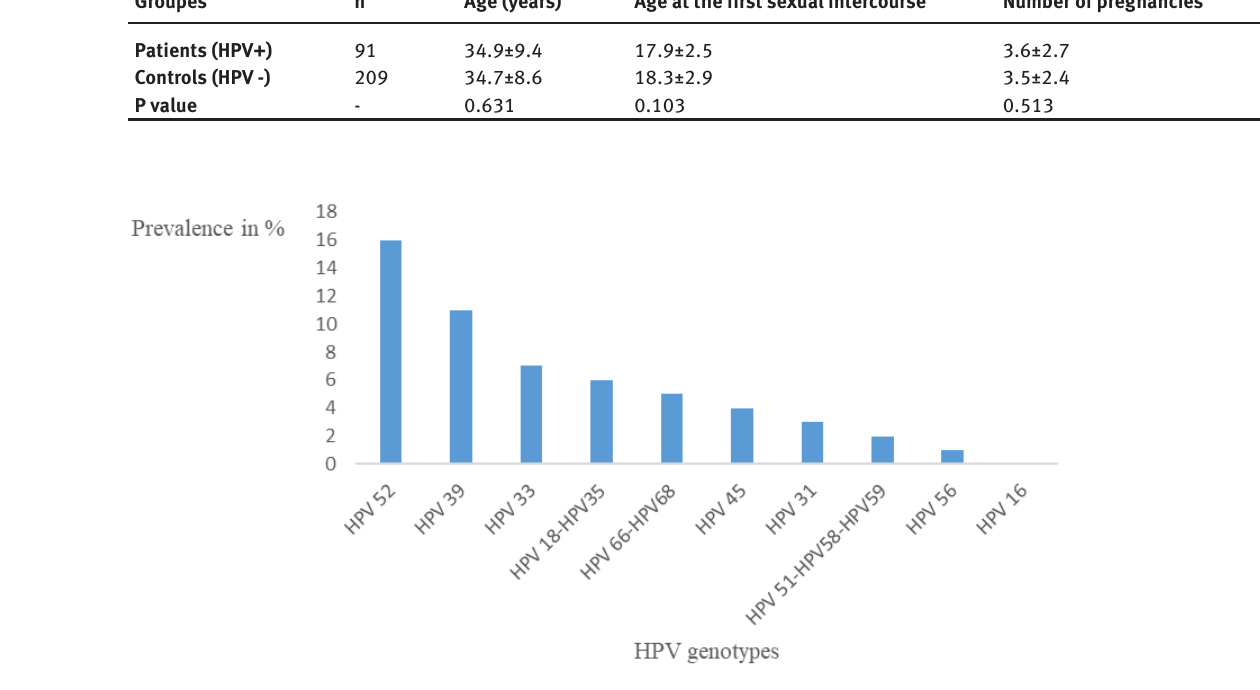
Figure 1 : Frequencies of high-risk HPV genotypes found among